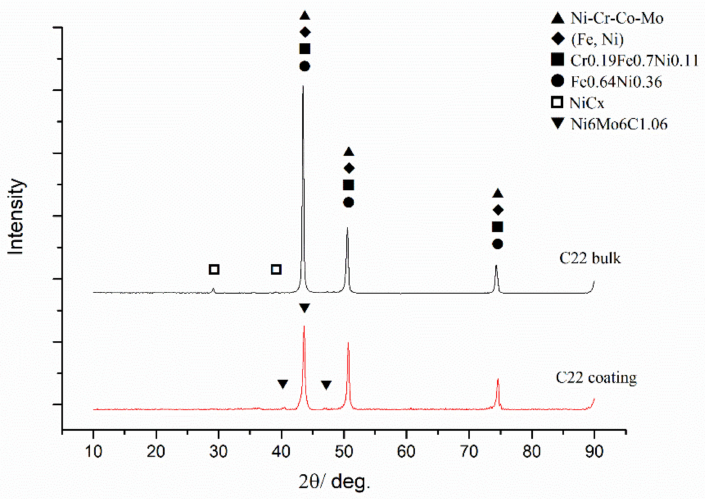
Figure 2. XRD patterns of C22 bulk and the C22